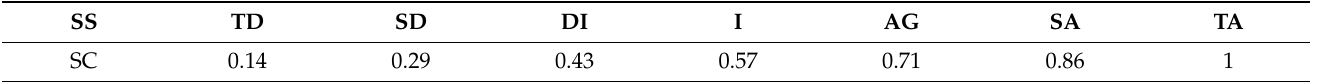
Table 9. Semantic